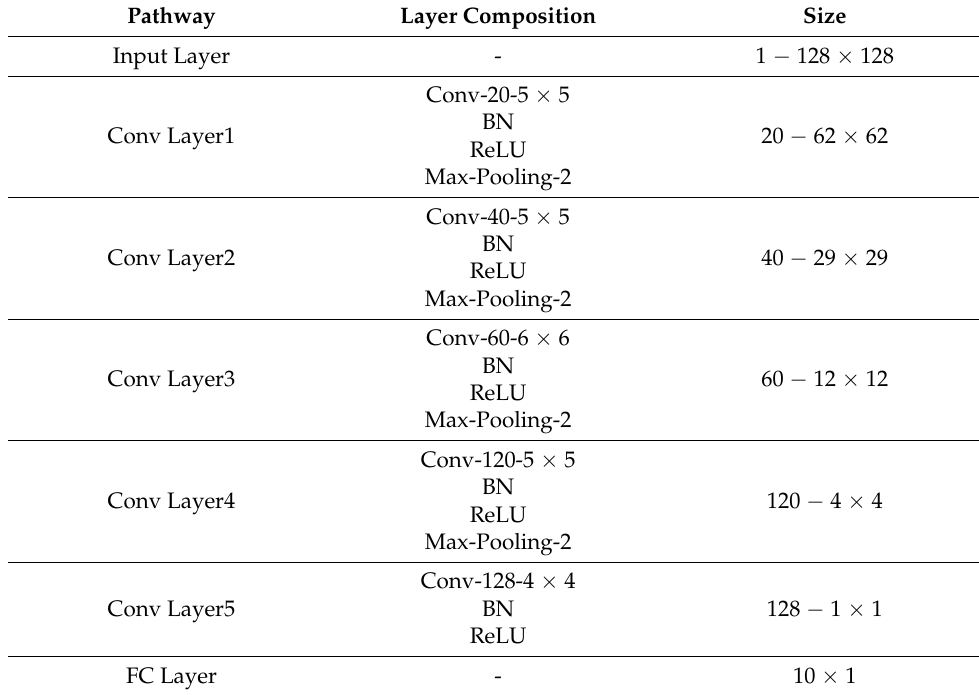
Table 1. The network configuration of